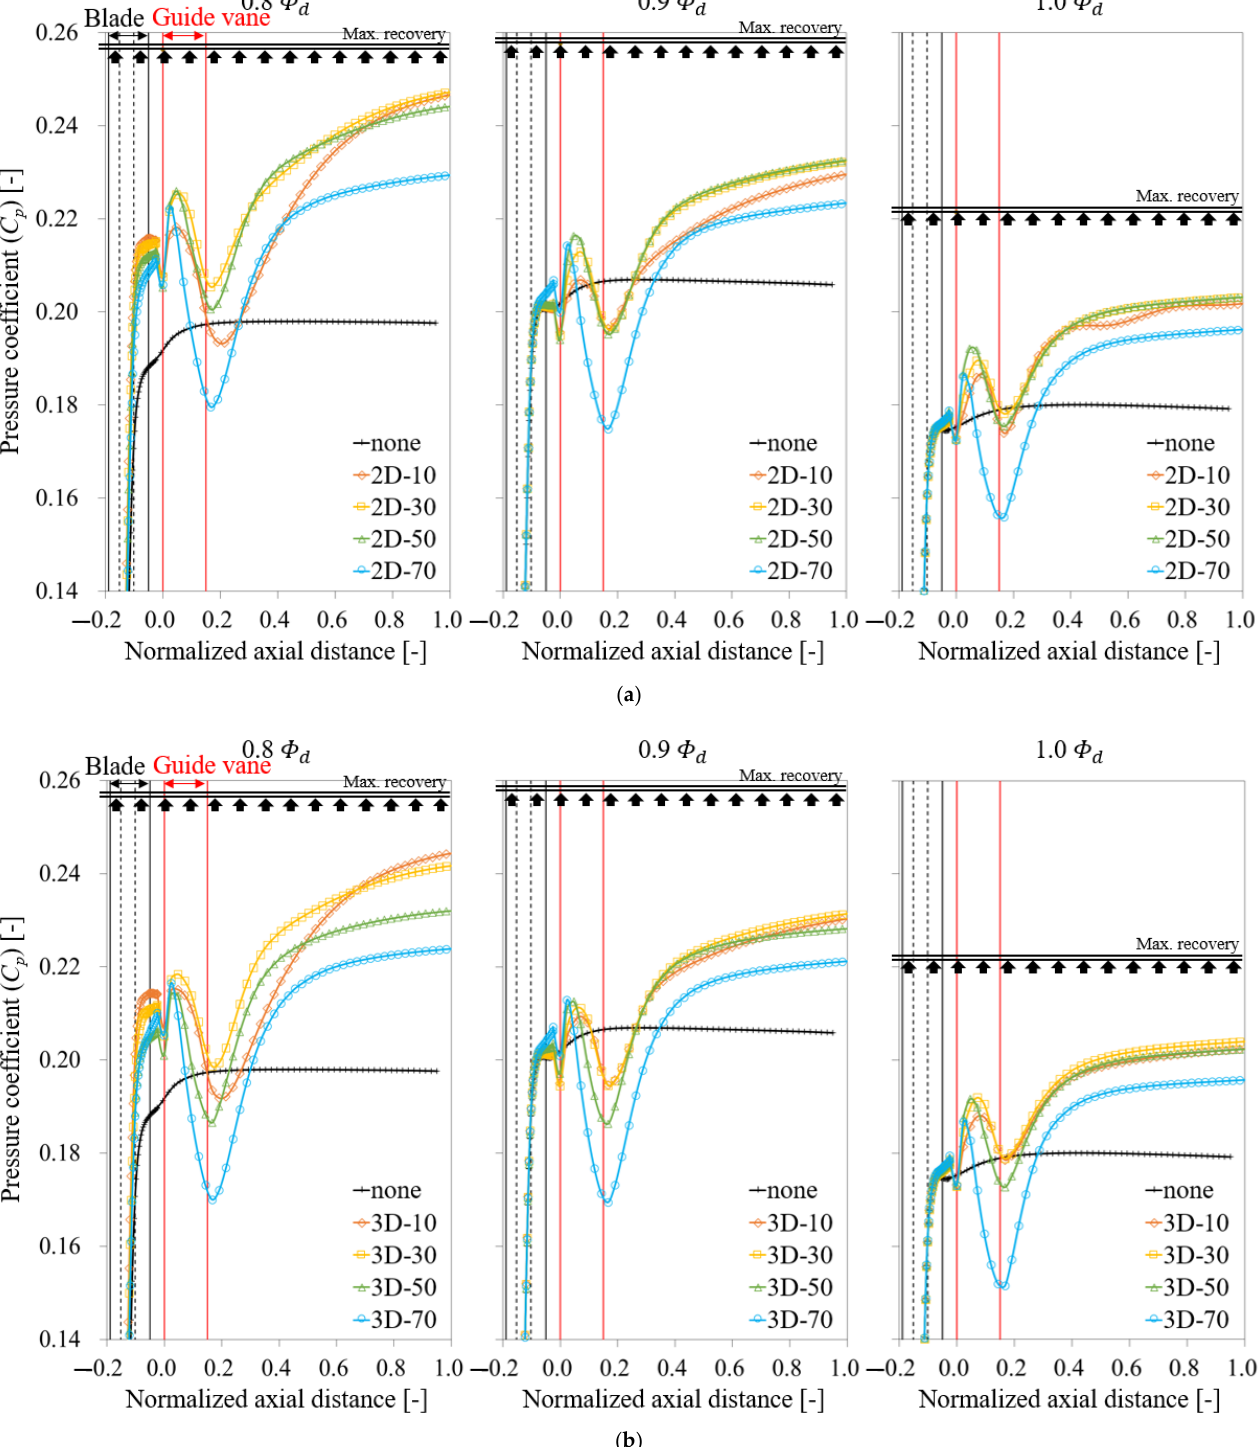
Figure 12. Static pressure rise in axial distance: ( a ) 2D design; ( b ) 3D design. First, Figure 12a relates to the 2D design. At 1.0 Φ d (design point), the static pressure rise, which showed almost the same pattern before passing through the blade,